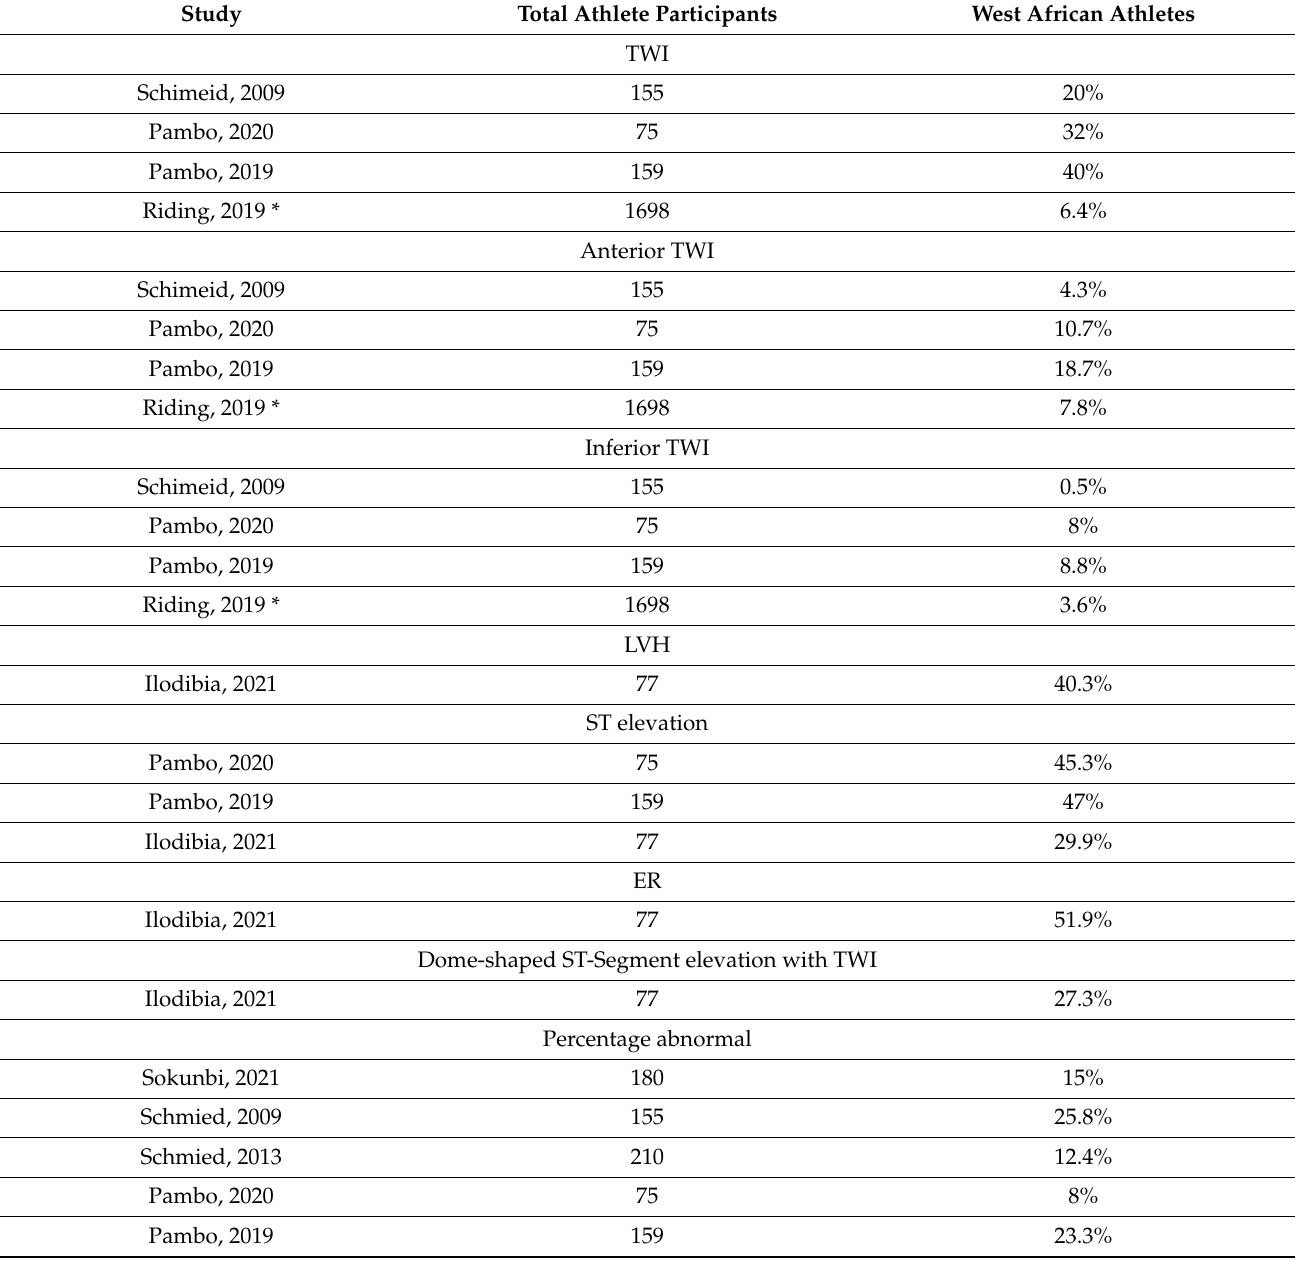
Table 2. Percentages of ECG changes in West African